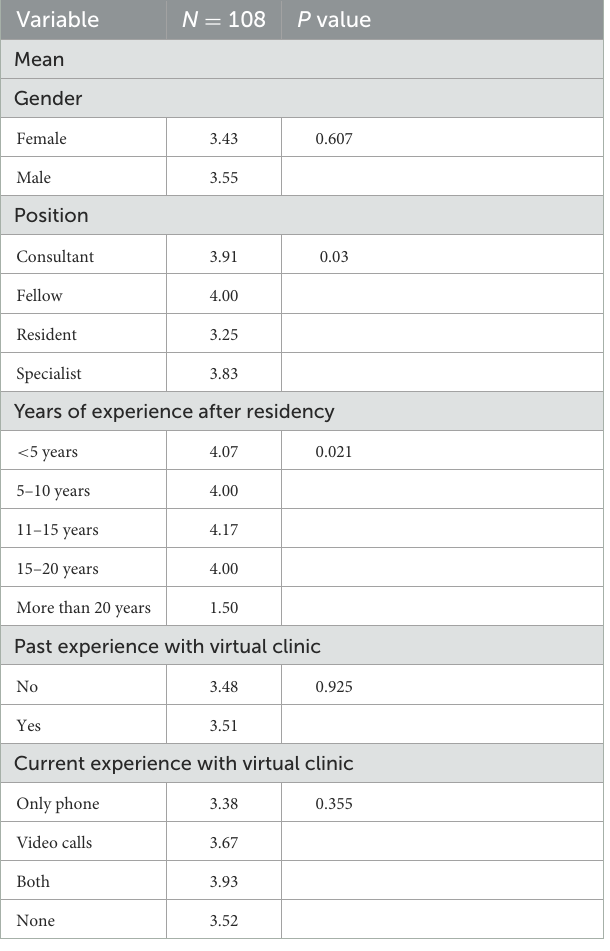
TABLE 5 Correlation between virtual clinic continuation and